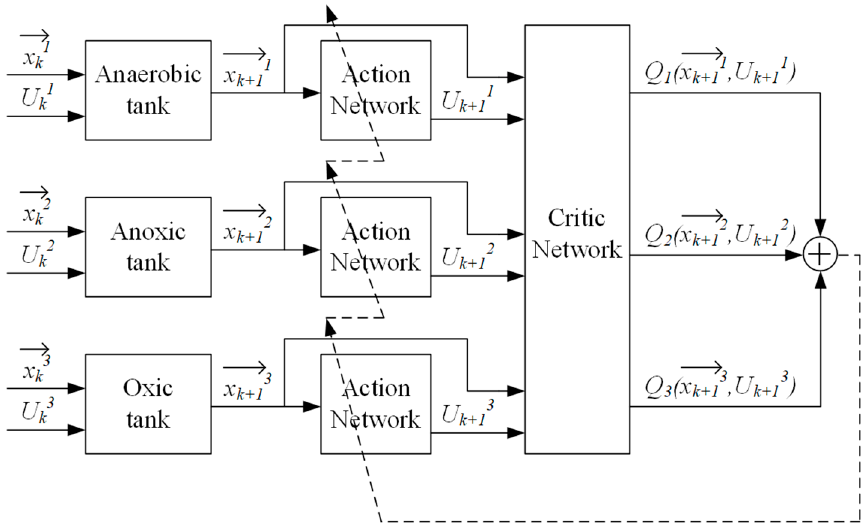
Figure 3. The logical relationship diagram of the HRTs optimal control for the AAO system.